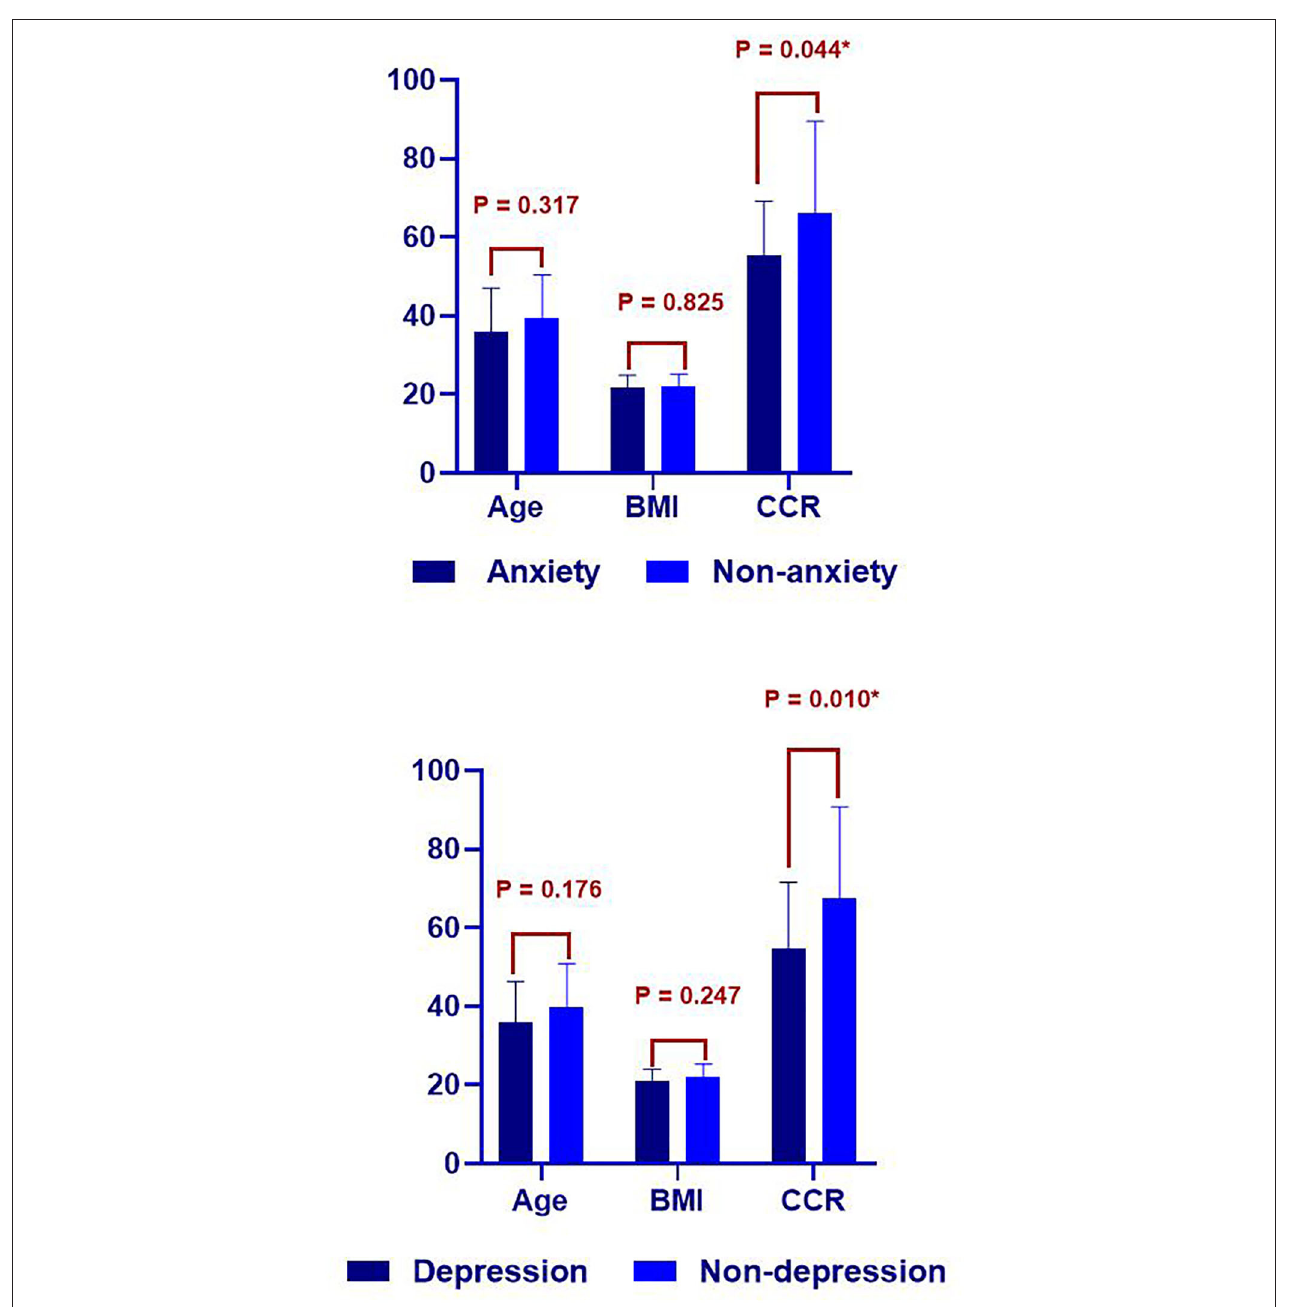
FIGURE 1 | Comparison of age, body mass index (BMI), and creatinine clearance rate (CCR) between the anxiety and non-anxiety groups, and the depression and non-depression groups.